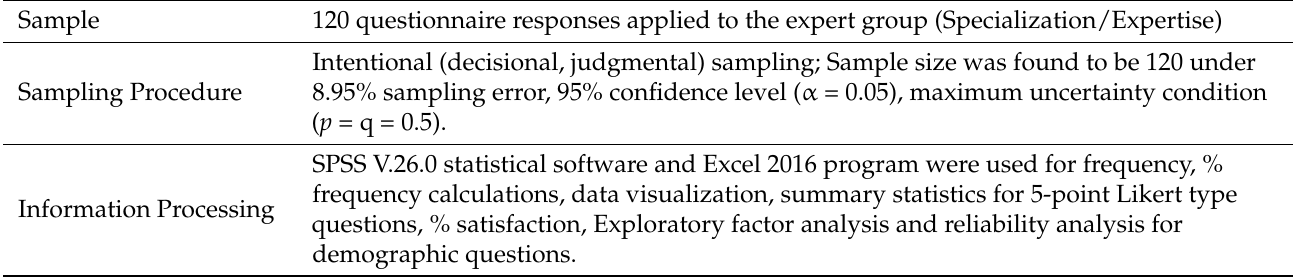
Table 2. Descriptive information about the sample.